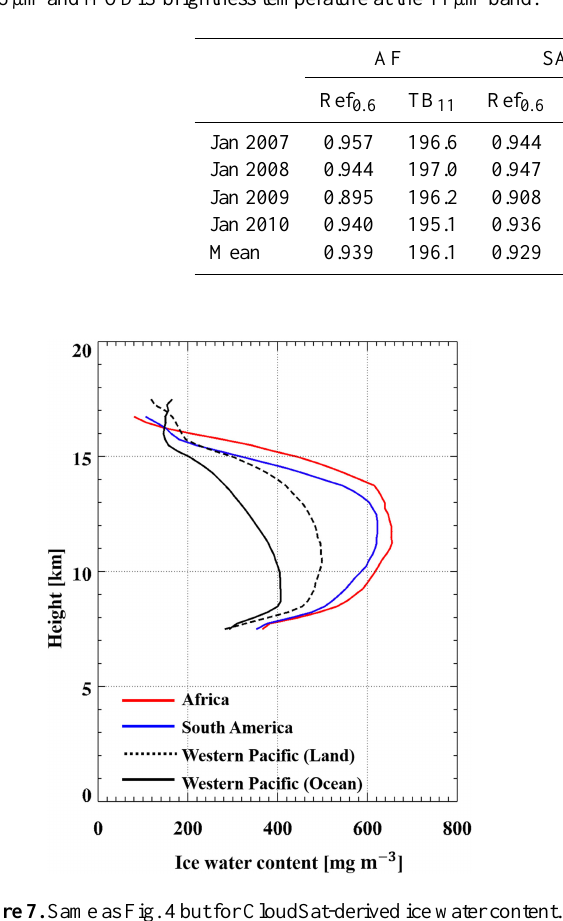
ent between the western Pacific and tropical land